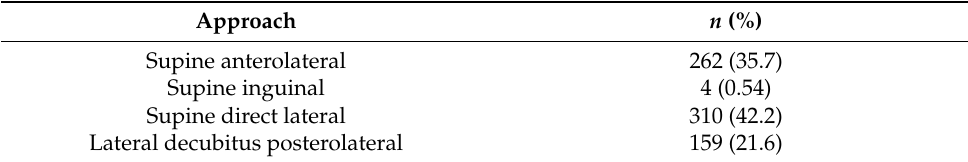
Table 3. Surgical approach.